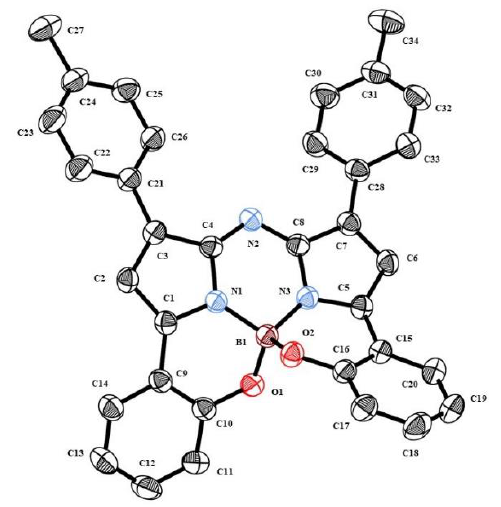
Figure 2. Molecular structure of 1a . Ellipsoids are drawn at the 40% probability level. Hydrogen atoms have been removed for clarity.